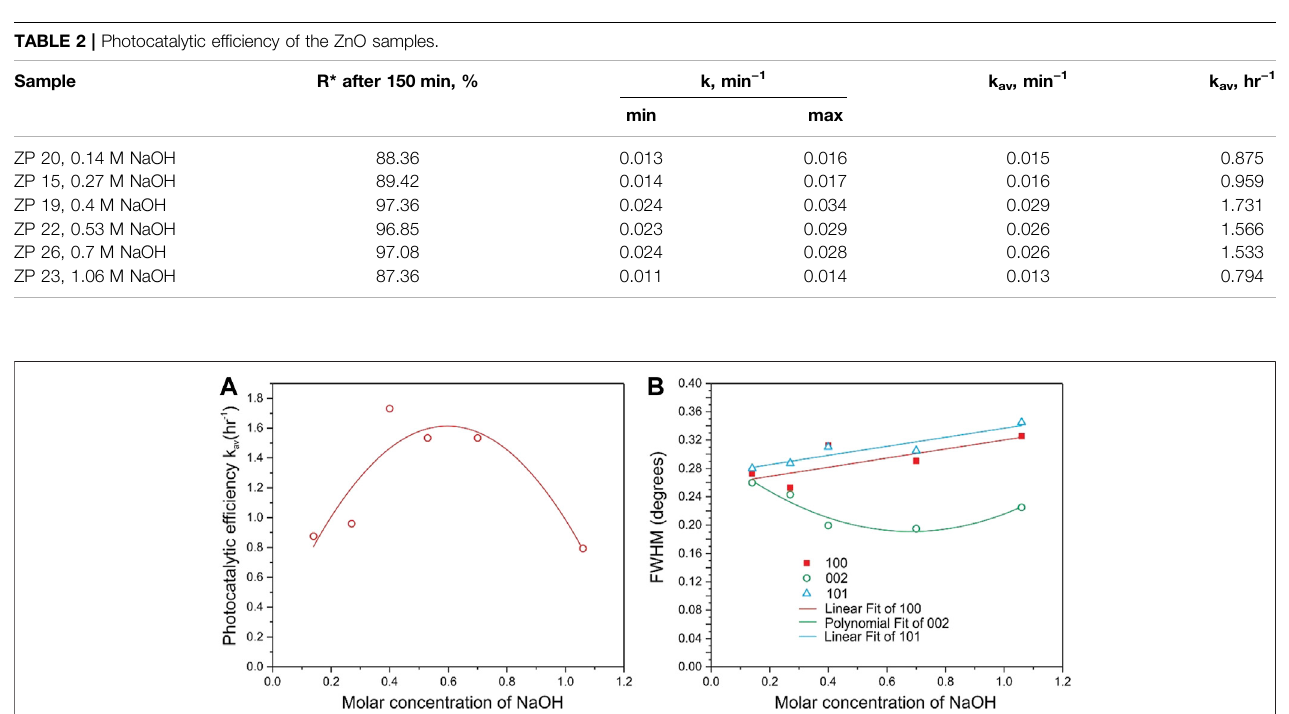
Frontiers in Materials |